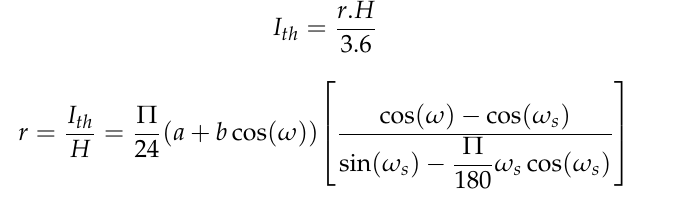
 = sunset hour angle (degree) and is given in Equation (3). s